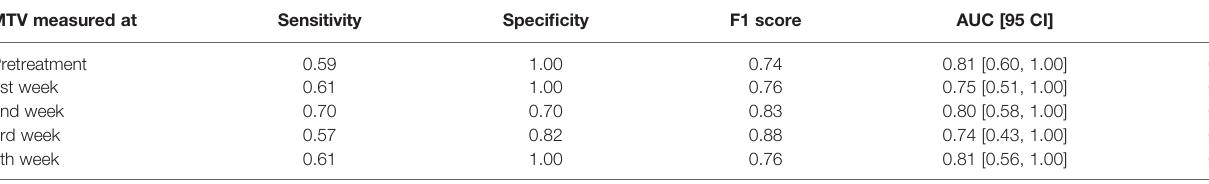
TABLE 4 | ROC results for the metabolic tumor volume (MTV). MTV measured at